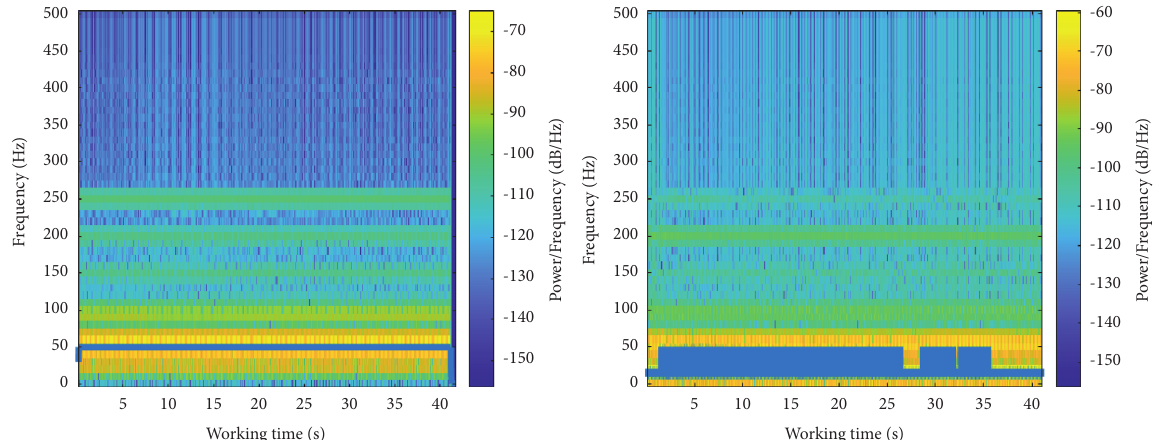
Figure 30: Spectral response analysis for two supports. (a) Composite beam. (b) Single beam